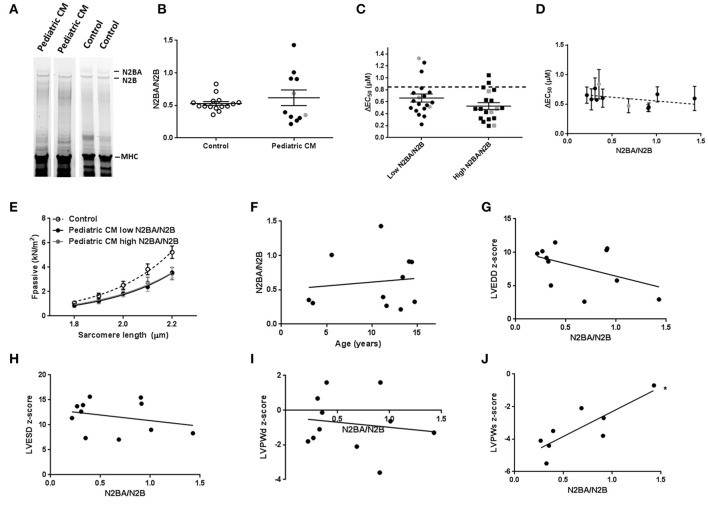
Titin isoform composition has limited effect on contractility in pediatric CM. (A) Separation of titin N2BA and N2B with gel electrophoresis. (B) N2BA/N2B ratio was not significantly different between pediatric CM (0.62 ± 0.12, N = 11) and controls (0.53 ± 0.03, N = 15). (C) Length-dependent activation was mostly impaired in pediatric CM patients who had higher N2BA/N2B ratio (N2BA/N2B > 0.65, N = 5, n = 19) compared to pediatric CM patients who had lower N2BA/N2B ratio (N2BA/N2B < 0.4, N = 6, n = 19). Dotted line indicates control values. (D) Mean ΔEC50 per sample plotted against the N2BA/N2B ratio did not show a significant correlation between ΔEC50 and N2BA/N2B. (E) There was no difference in Fpass between pediatric CM patients who had higher N2BA/N2B ratio (N2BA/N2B > 0.65, N = 5, n = 18) and pediatric CM patients who had lower N2BA/N2B ratio (N2BA/N2B < 0.4, N = 6, n = 22). (F) N2BA/N2B ratio was not significantly related to age. (G) No significant correlation was found between N2BA/N2B and LVEDD z-score. (H) No significant correlation was found between N2BA/N2B and LVESD z-score. (I) No significant correlation was found between N2BA/N2B and LVPWd z-score. (J) A significant correlation was found between N2BA/N2B ratio and LVPWs z-score (p < 0.05). N, number of samples; n, number of cardiomyocytes measured. Measurements obtained from samples derived from patients with non-compaction cardiomyopathy are indicated in gray (B–D).